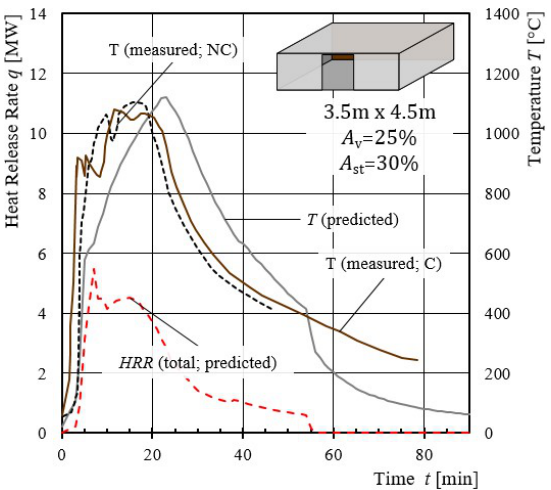
Figure 15: Predicted and measured temperatures for the predicted total HRR for experiment III.